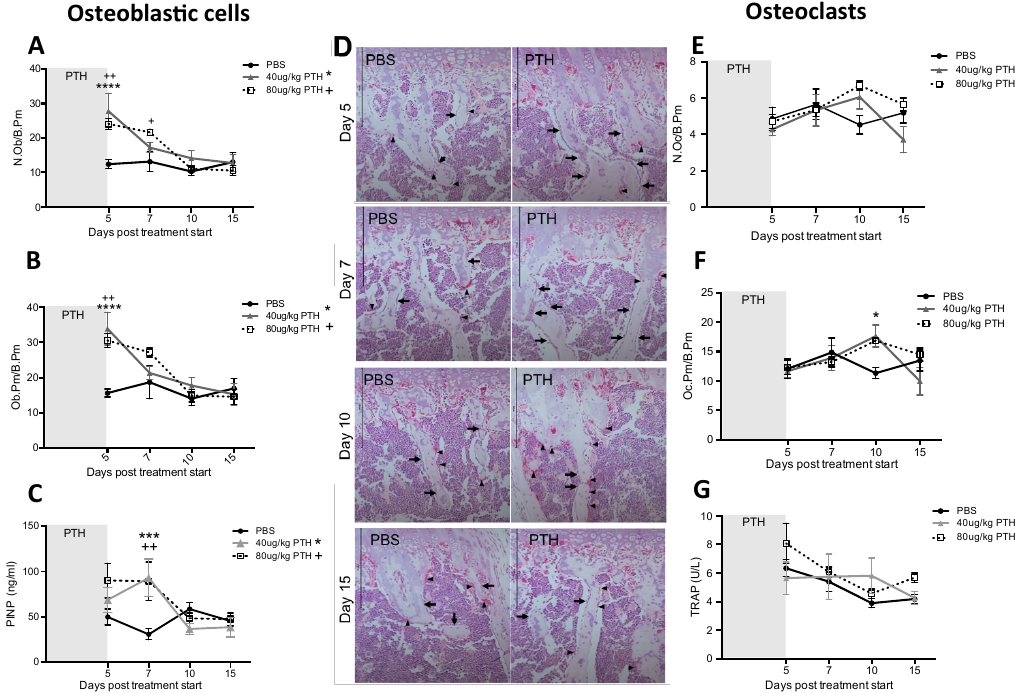
Figure 3. Intermittent PTH treatment induces changes to the bone microenvironment. Animals were treated with 40 µ g/kg or 80 µ g/kg PTH or PBS for 5 days and culled on day 5, 7, 10 and 15. TRAP stained histological sections of tibias were used to assess. ( A ) the number of osteoblasts per mm trabecular bone surface (N.Ob/B.Pm) and ( B ) the percentage of trabecular bone in contact with osteoblasts (Ob.Pm/B.Pm). ( C ) Serum was used for the analysis of the bone formation marker PINP by ELISA. ( D ) Representative TRAP images of sections from PTH and PBS treated mice. Osteoclasts are stained in bright pink (black arrowhead). Arrows show rows of osteoblastic cells. Scale bar = 100 µ m. ( E ) Osteoclasts per mm trabecular bone surface (N.Oc/B.Pm) and ( F ) percentage of osteoclasts in contact with trabecular bone surfaces (Oc.Pm/B.Pm) were scored on histological sections stained for TRAP. ( G ) Serum marker of bone resorption (TRAP) was measured by ELISA. Data is presented as mean ± SEM and statistical analysis was performed using two-way ANOVA and multiple comparison post-test. * is 40 µ g/kg PTH vs. PBS and * is p < 0.05, *** is p < 0.001 and **** is p < 0.0001. + is 80 µ g/kg PTH vs. PBS and ++ is p < 0.01. A minimum of n = 4 animals per time point and treatment group were analyzed.